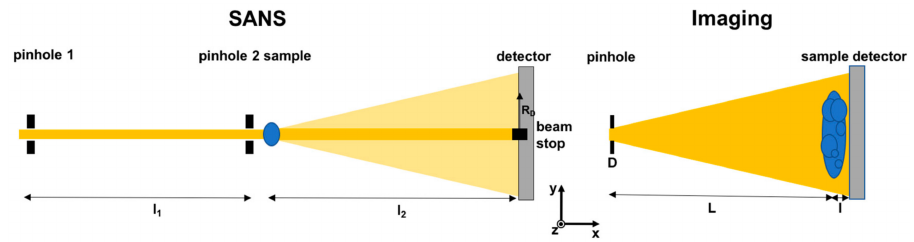
Figure 1. Instrument set-ups: conventional small angle neutron scattering (SANS) [1] and imaging geometry [2] and